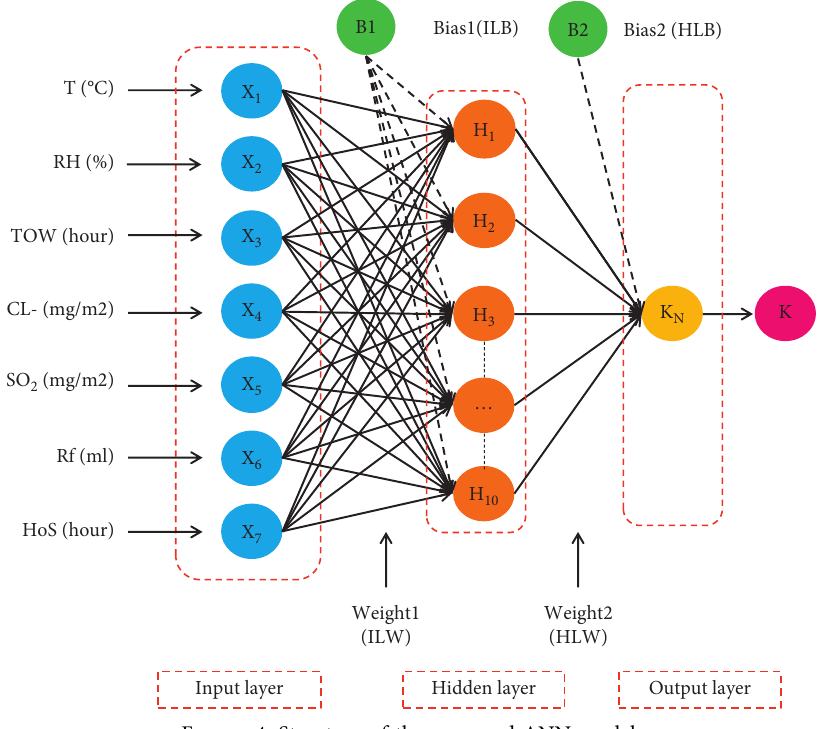
Figure 4: Structure of the proposed ANN